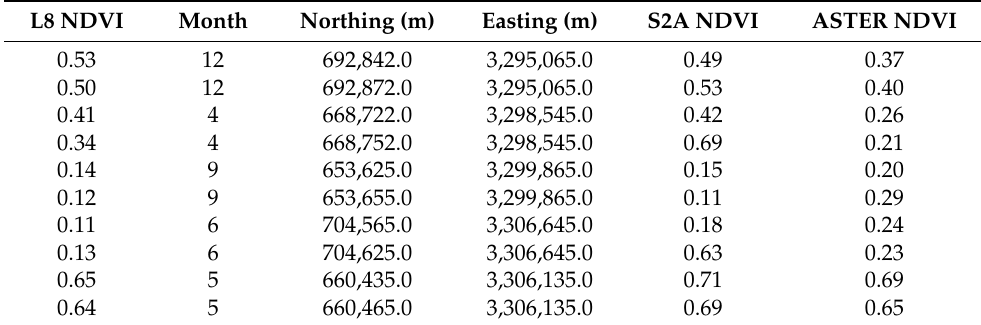
Table 2. Sample data for training virtual constellation